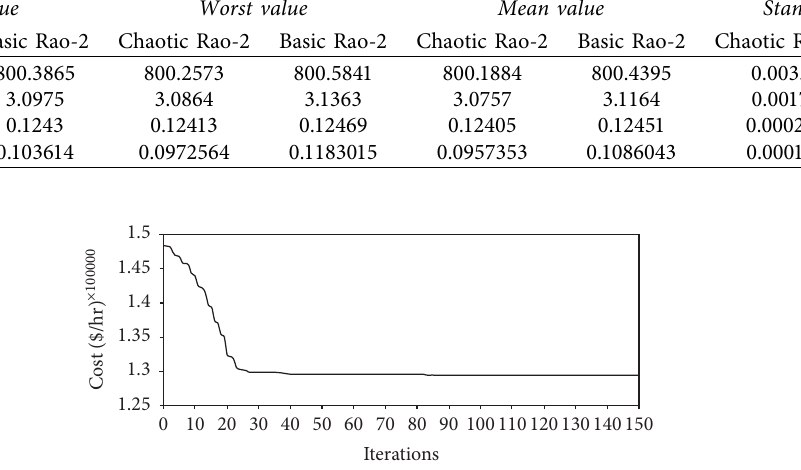
Figure 9: Convergence graph obtained for case 6 using the chaotic Rao-2